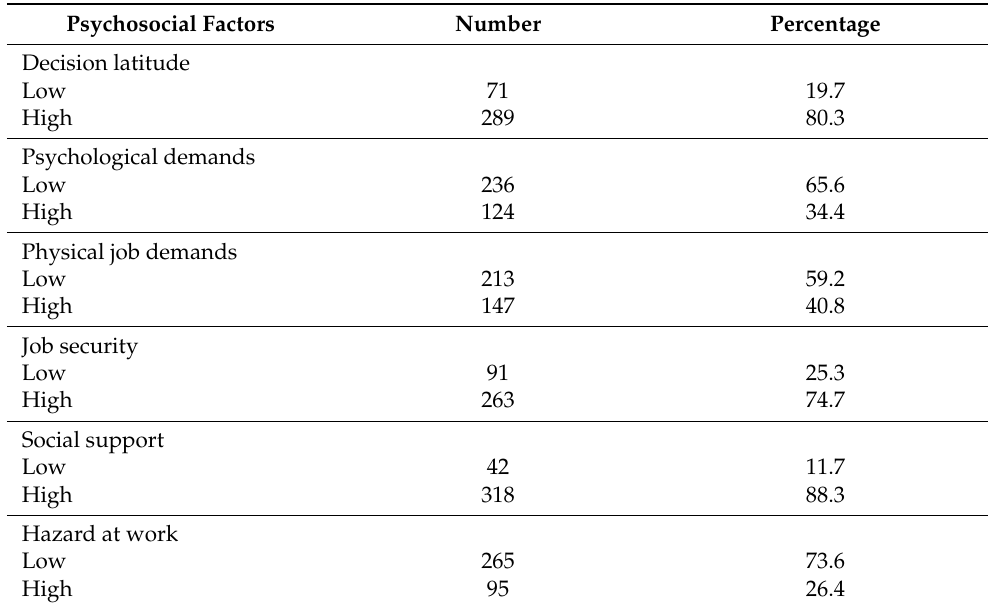
Table 2. Psychosocial factors at work ( n =